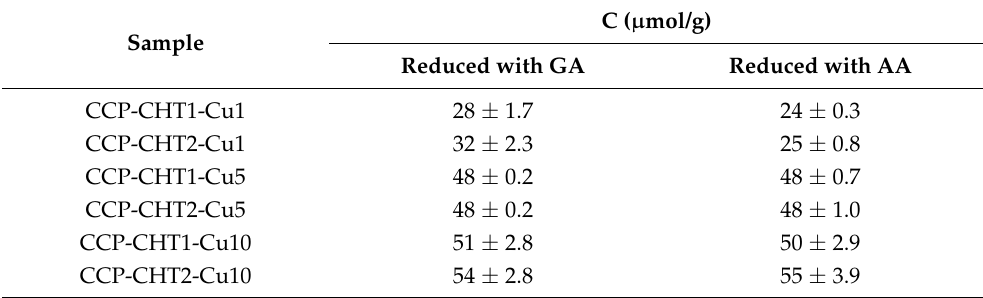
Table 1. Total copper content (C) in nanocomposites.